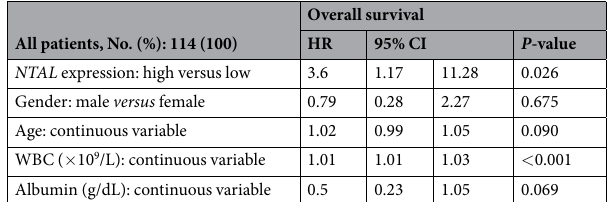
Table 2. Multivariable Cox model for overall survival. Note: Hazard ratio (HR) > 1 or < 1 indicates an increased or decreased risk, respectively, of an event for the first category listed.